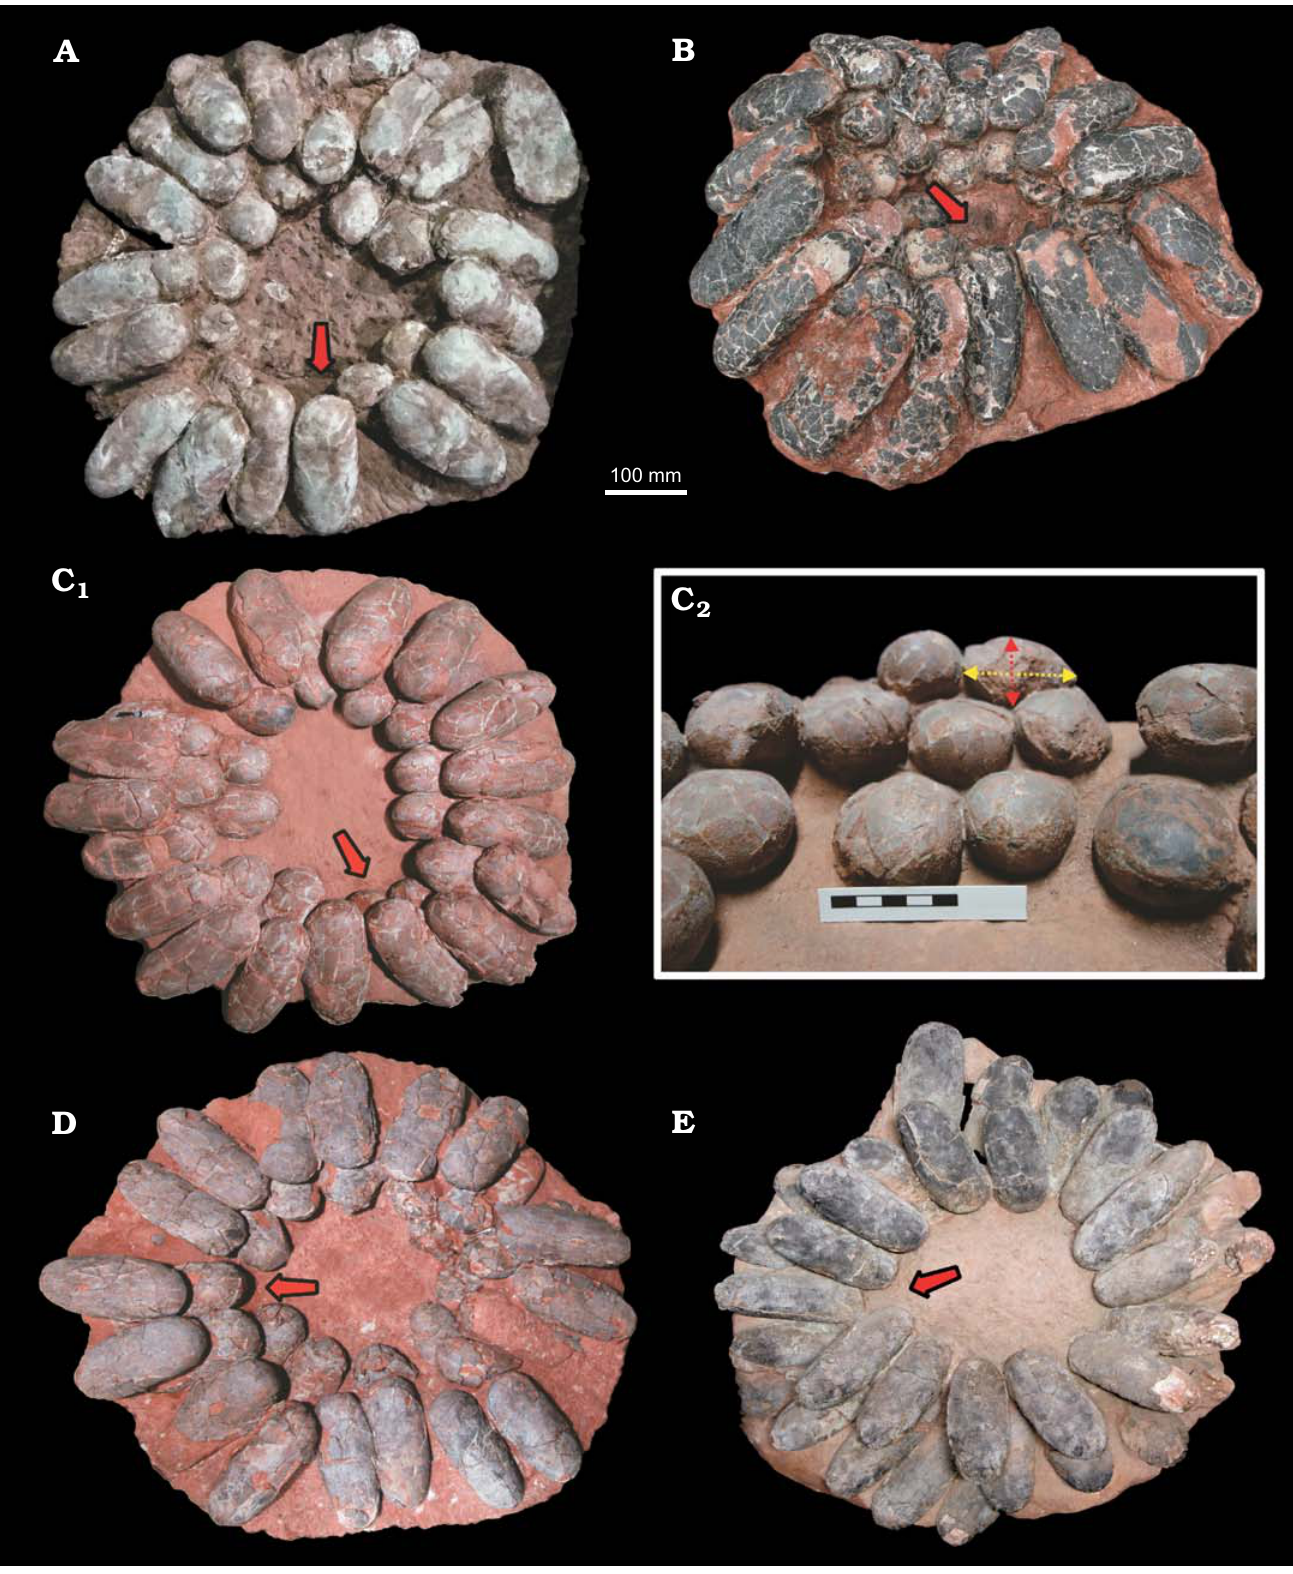
rings of eggs are separated by thin layers of sediments; yellow dashed line, the major axis (46 mm); red dashed line, the minor axis (24 mm); scale bar 50 mm. D . Top view of PFMM-0014004392, a complete clutch with 32 eggs arranged in three superimposed rings. The vacant center is 200 × 186 mm. E . Bottom view of PFMM-0014003019, a complete clutch with 35 eggs arranged in three superimposed rings. The vacant center is 293 × 280 mm, which is the largest opening among the specimens described in this study. Arrows point to the opening in the lowermost